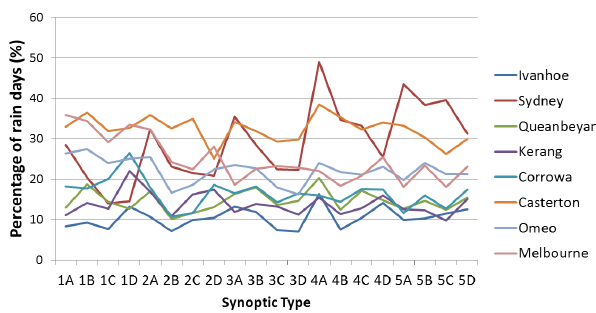
Figure 14. Percentage of rain days associated with each winter syn- optic